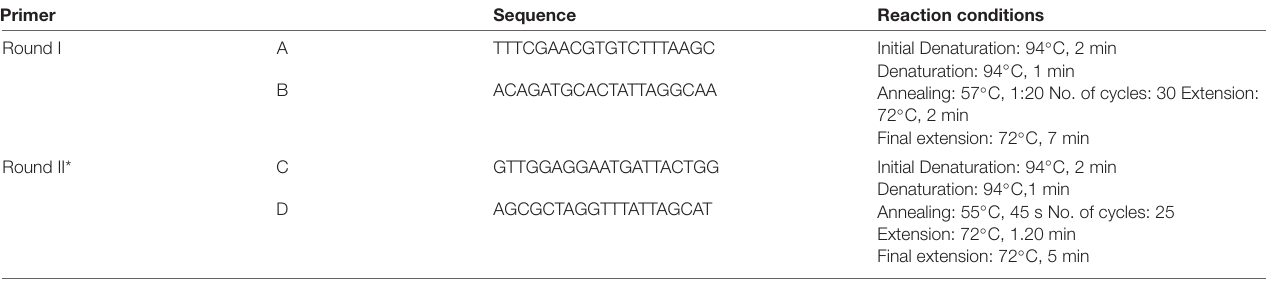
TABLE 1 | Primers and conditions used for PCR and sequencing.